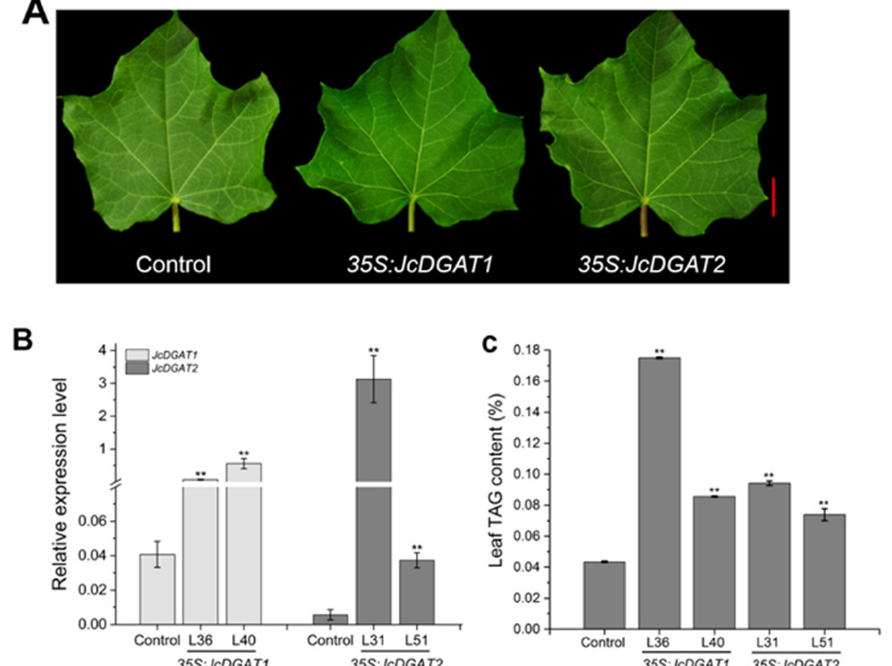
Figure 5. Triacylglycerol (TAG) contents accumulated in transgenic lines with normal phenotypes. ( A ) Phenotypes of leaves from the control and transgenic plants during the period of fruiting. Scale bar = 2 cm. ( B ) The expression levels of JcDGAT1 and JcDGAT2 in the control and 35S:JcDGATs transgenic leaves. ( C ) TAG contents in the leaves of control and transgenic plants. The values are presented as the mean ± standard deviation of two biological replicates. The student’s t -test was used for statistical analyses. ** p ≤ 0.01.